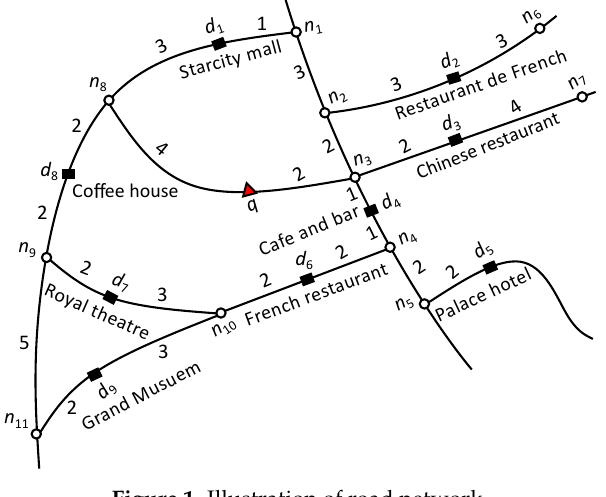
Figure 1. Illustration of road network.